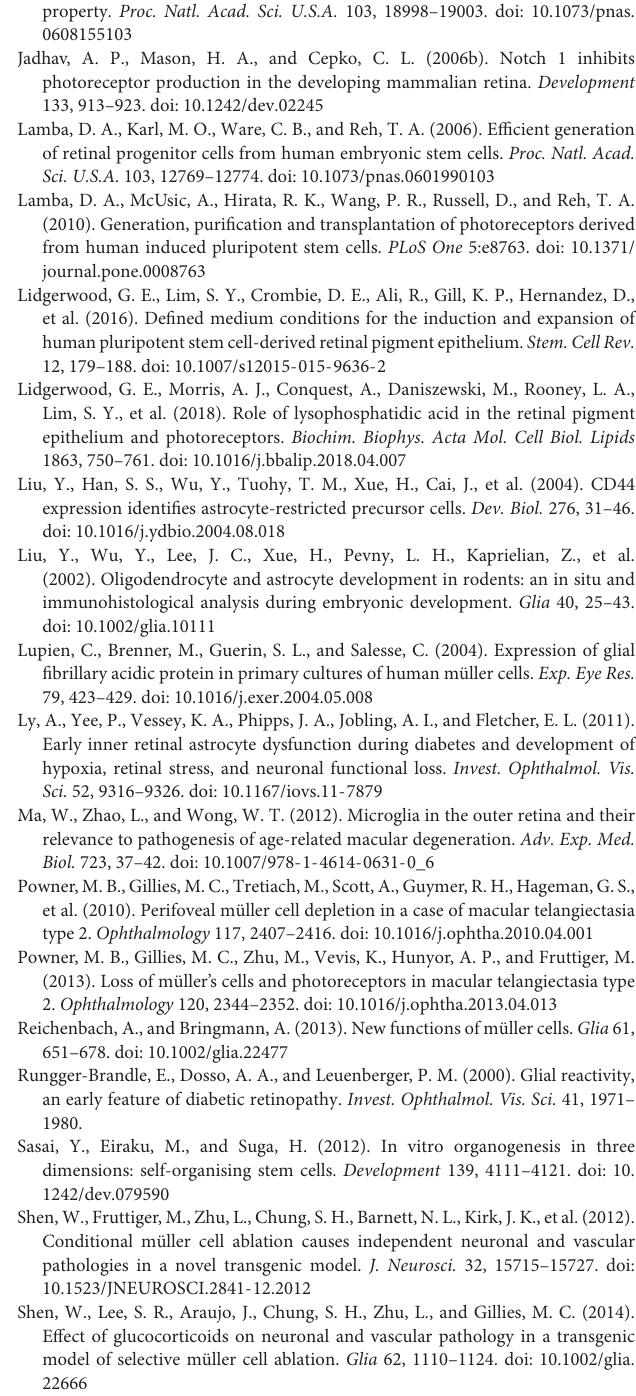
FIGURE S4 | FACS analyses of GFAP + cells 4 and 6 weeks after Notch ligand treatment in H9-derived RPCs. The number of GFAP + cell was counted from 10,000 events. (A,C) Notch treatment for 4 weeks increased the number of GFAP + cells compared with un-treated RPCs cultured for 7 weeks. (B,D) There was a decrease in the number of GFAP + cells in both groups after incubation in test media for further 2 weeks. Error bars represent SEM, n =